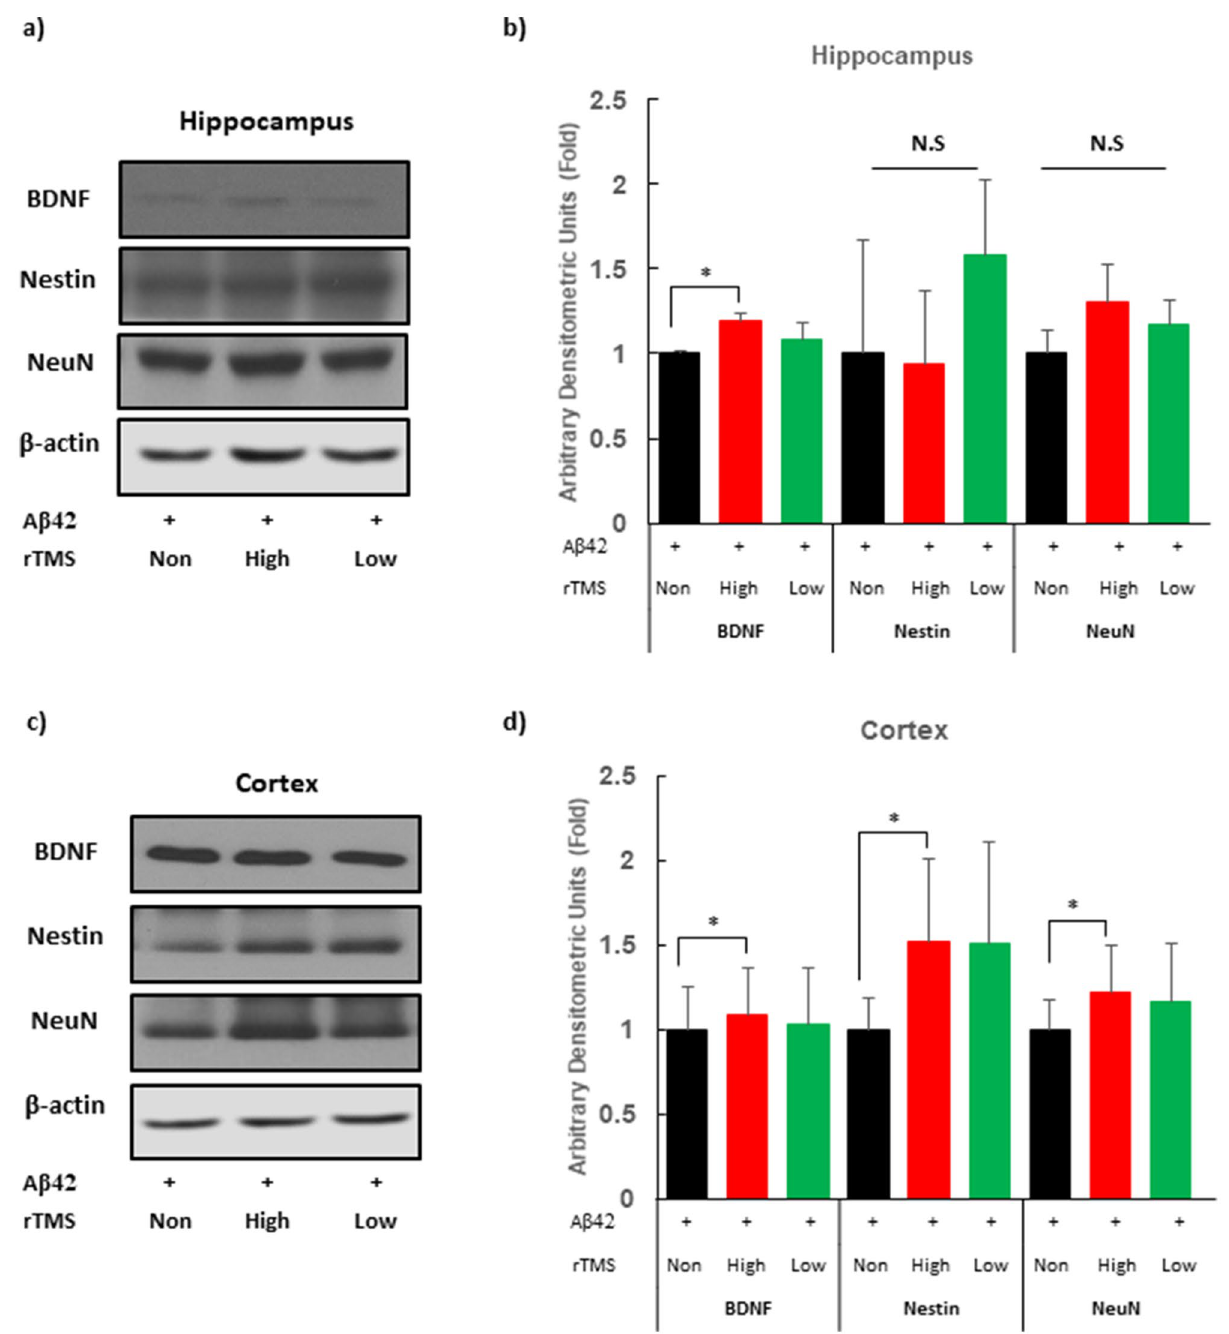
Figure 1. A correct version of the original Figure 4. rTMS upregulates neurogenic expressions in AD mouse model. ( a ) Protein expression of hippocampal BDNF, Nestin and NeuN protein was measured by western blot. ( b ) Histograms show densitometry analysis of the western blot in hippocampus. ( c ) Protein expression of cortex BDNF, Nestin and NeuN protein was determined by the western blot. ( d ) Histograms show densitometry analysis of the western blot in cerebral cortex. Protein level of actin was analysed as a loading control. Mean data normalised to β-actin are in bar graphs compared with control. Each group n = 4, mean ± SEM.* Ps < 0.05. + Aβ42 oligomer injected via ICV, rTMS repetitive transcranial magnetic stimulation, AD Alzheimer’s Disease, BDNF brain-derived neurotrophic factor, Aβ42 amyloid beta 42 oligomer, None none treatment, High high frequency rTMS treated, Low low frequency rTMS treated, N.S. not